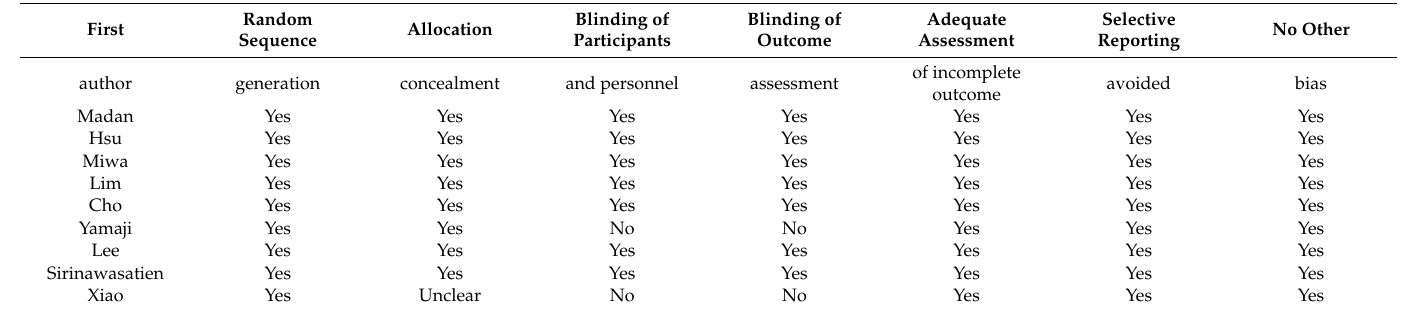
Table 2. Evaluation of bias of RCTs included in the systematic